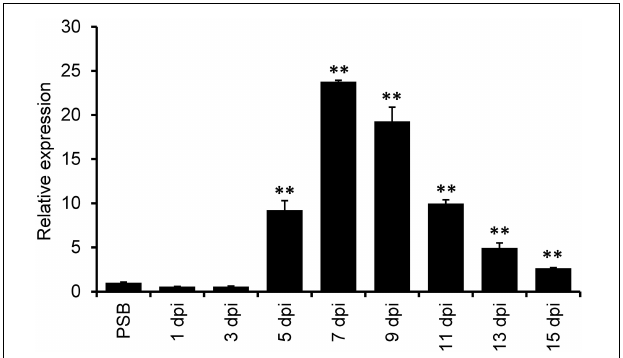
FIGURE 1 | Expression analysis of UvCBP1 during Ustilaginoidea virens infection in rice. Spikelets from PJ52-inoculated rice panicles were sampled at indicated time points and subjected to RT-qPCR analysis. The mixture of mycelia and conidia from PSB-cultured PJ52 was collected as the control sample. Relative expression level of UvCBP1 was determined using UvTub2 α as the reference gene. Data are represented as means ± SD of three biological replicates. Asterisk indicates significant difference determined by Student’s t test ( ∗∗ P < 0.01). Similar results were obtained from two independent experiments. dpi, day post